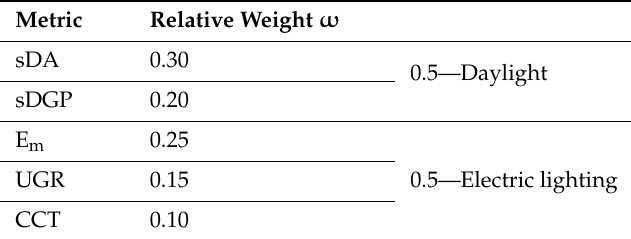
Table 3. Relative weights ( ω ) of the